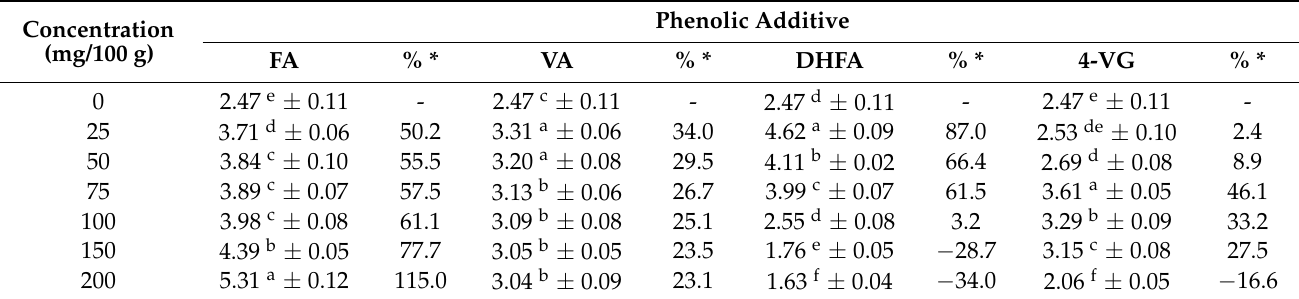
Table 1. Predicted shelf life (x ± SD) at 20 ◦ C (months) of cold-pressed flaxseed oil with addition of phenolic